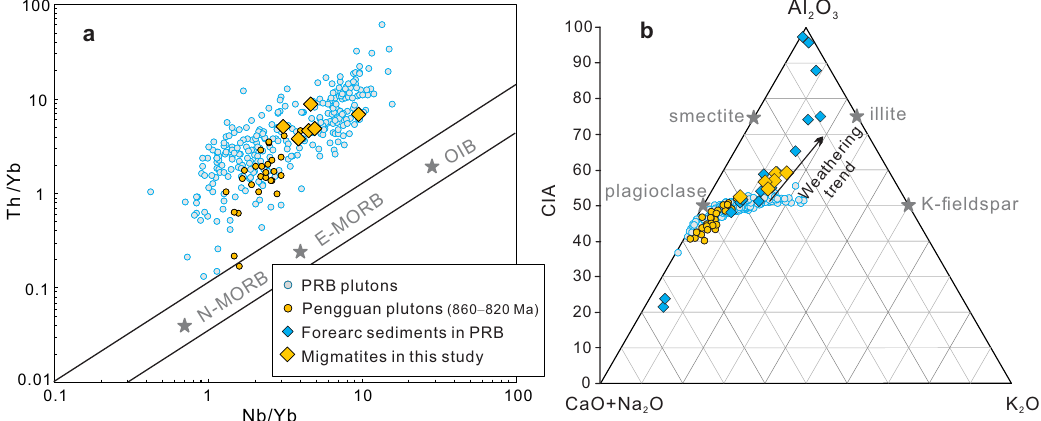
Fig. 3 Geochemical af fi nity of the Pengguan migmatites compared with those of 860 – 820 Ma plutonic rocks nearby, the plutonic rocks from Peninsular Ranges batholith (PRB) 44 and forearc sediments derived from PRB 45 . a The Nb/Yb-Th/Yb discrimination diagram is after Pearce 46 . b The A – CN – K – CIA (Chemical index of alteration) diagram is after Jiang and Lee 45 . OIB – Ocean-island basalt; E- and N-MORB – enriched and normal mid-ocean- ridge basalt. Data sources are provided in Supplementary Data